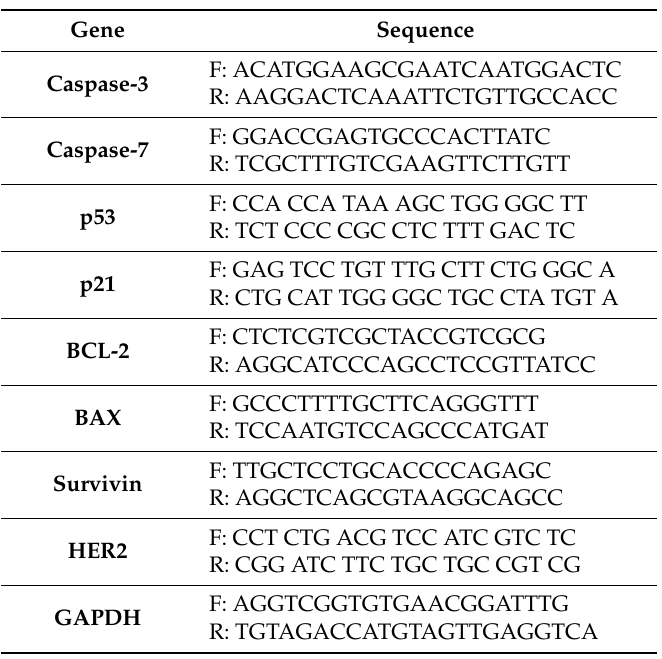
Table 1. Sequence of primers used in